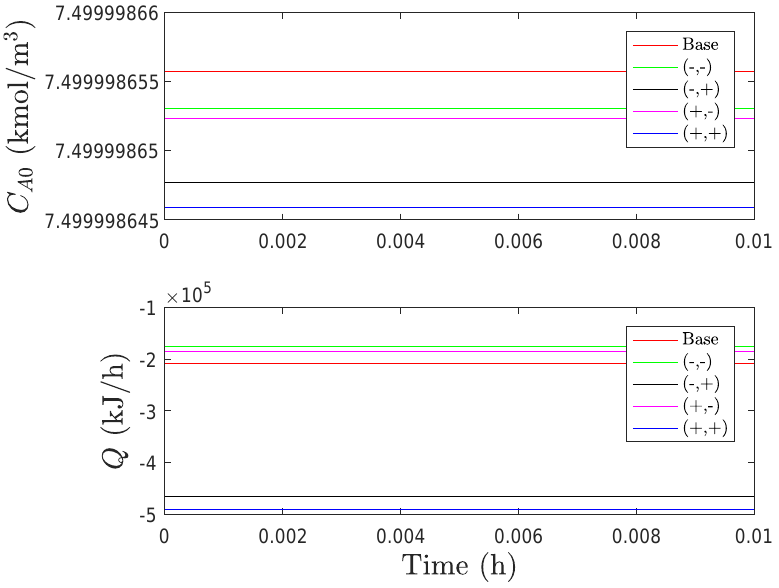
Figure 15. Input trajectories for x ( t 0 ) = ( − 0.243 kmol/m 3 , 52.75 K ) and the four